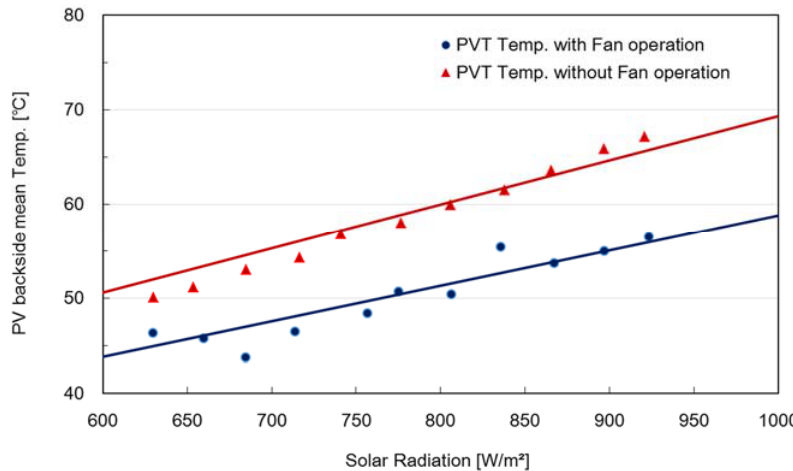
Figure 15. PV backside mean temperatures of the PVT with and without the operation of a fan during the non ‐ heating season.